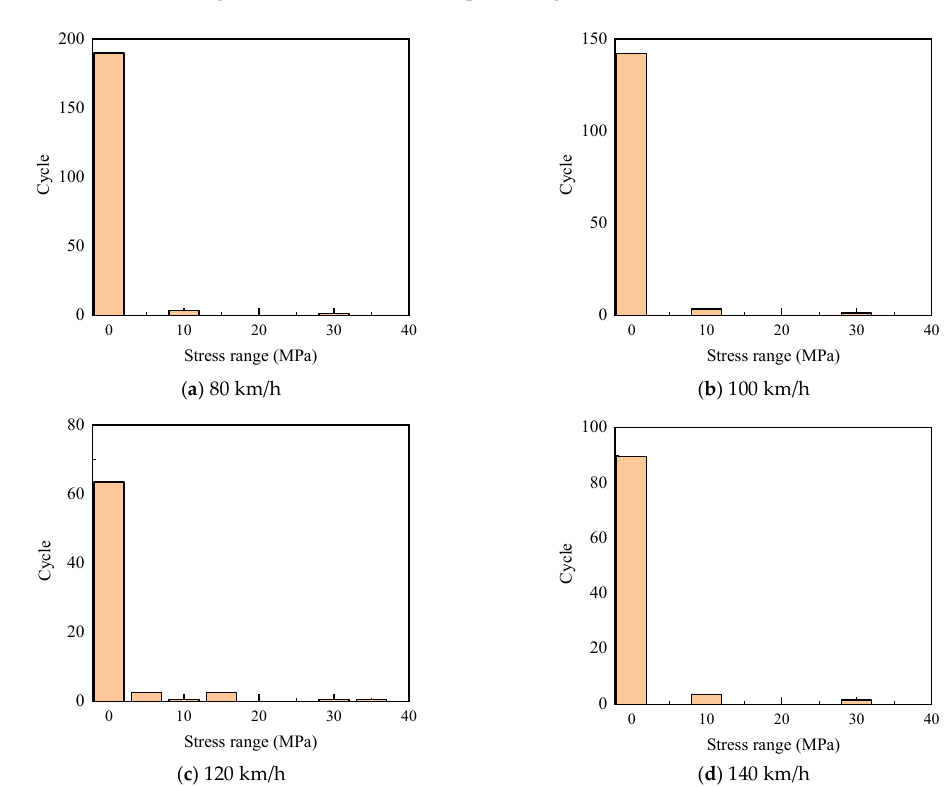
Figure 8. Stress range of steel rebar of 25 m-span bridge.